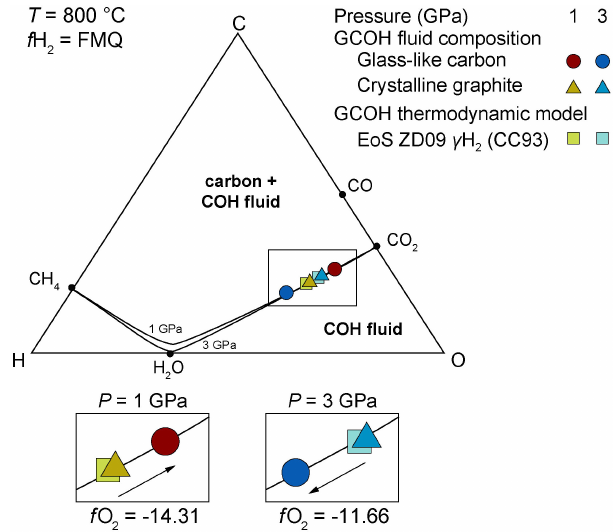
Figure 4. Measured volatile composition of carbon-saturated fluids at 1–3GPa and 800 ◦ C and f H 2 buffered by FMQ buffer, mod- ified from Tumiati et al. (2020). The volatile compositions were measured through quadrupole mass spectrometry (Tiraboschi et al., 2016) in equilibrium with crystalline graphite (triangles) and glass- like carbon (dots). In the diagram are also reported the two graphite saturation surfaces (solid black lines) at 1 and 3GPa, together with the volatile fluid composition predicted by the EoS of Zhang and Duan (2009) using the H 2 fugacity coefficient of Connolly and Ce- sare (1993) (squares). In the zoom boxes the different dissolution susceptibility of ordered and disordered graphitic carbon in aque- ous fluids is highlighted at 1 and at 3GPa. Oxygen fugacity values are reported as log f O 2 .